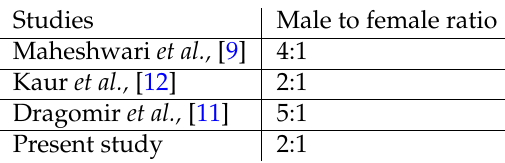
Table 4. Male to female ratio in co-ordnance with other studies